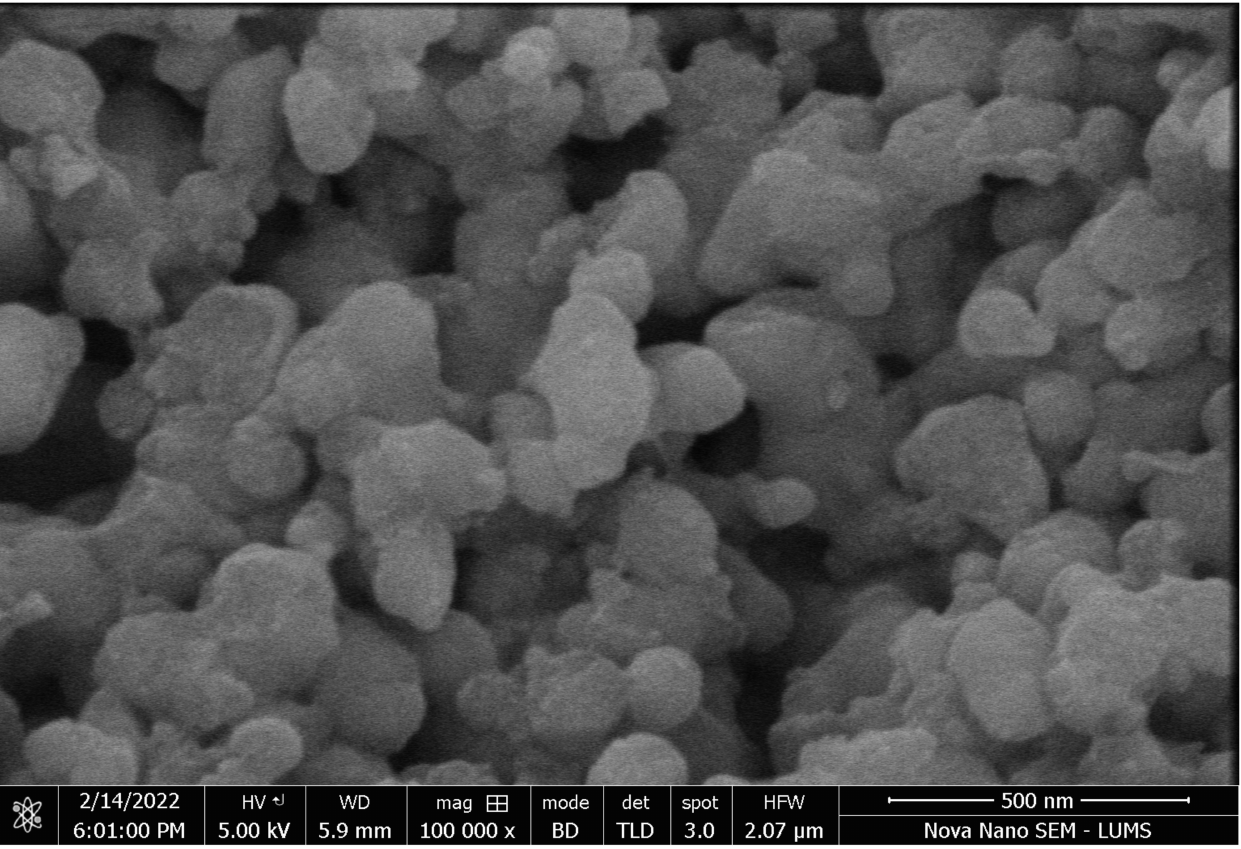
Figure 5. SEM images of CuO